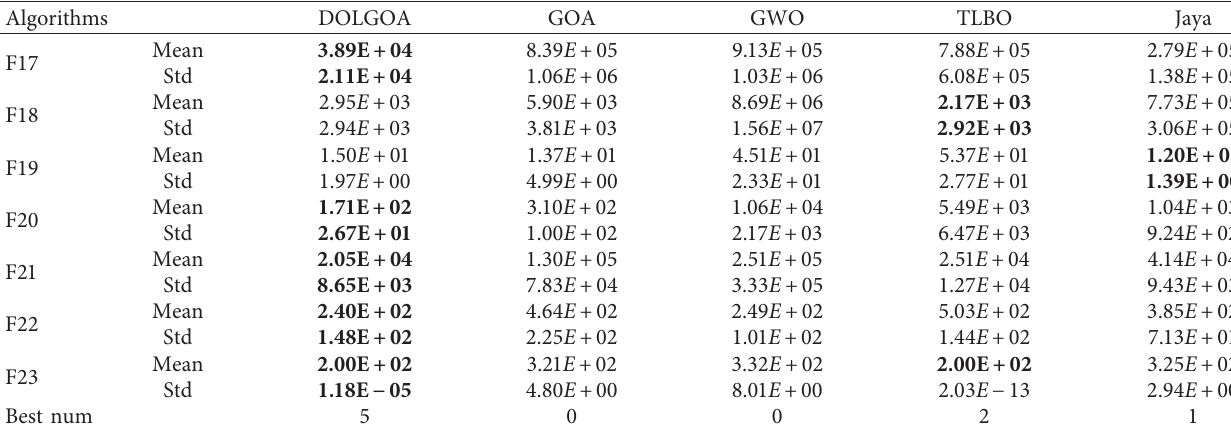
Table 5: The mean and standard value of hybrid test